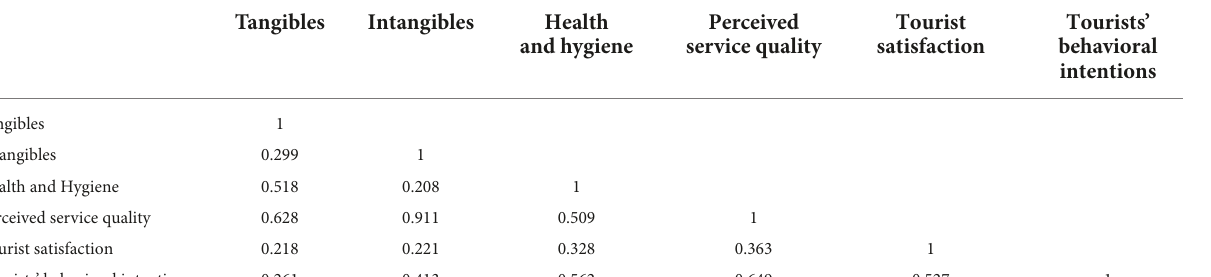
TABLE 7 Correlation matrix for the investigated dimensions.